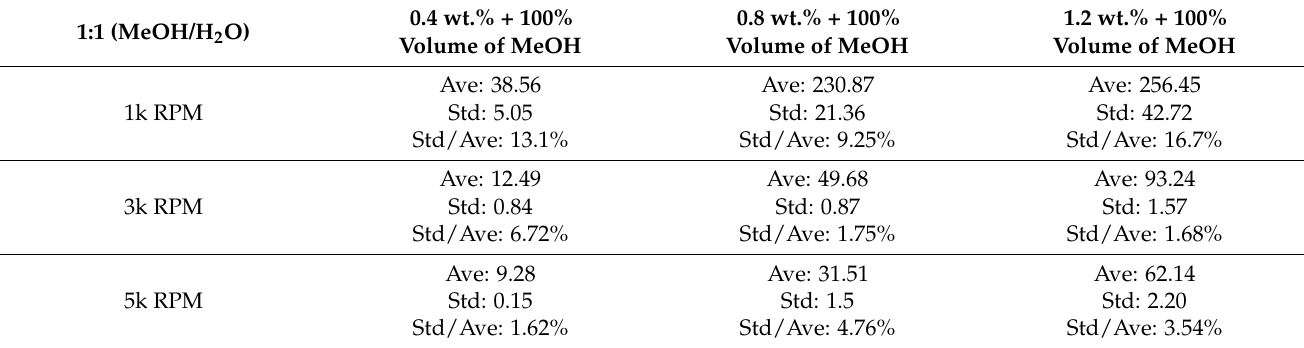
Table 4. Average thickness (nm) and standard deviation (nm) from 5 × 5 measurements of 1:1 MeOH/H 2 O DNA solution. An amount of 2 mL of aqueous DNA with varying DNA concentrations diluted with 2 mL of methanol solvent.